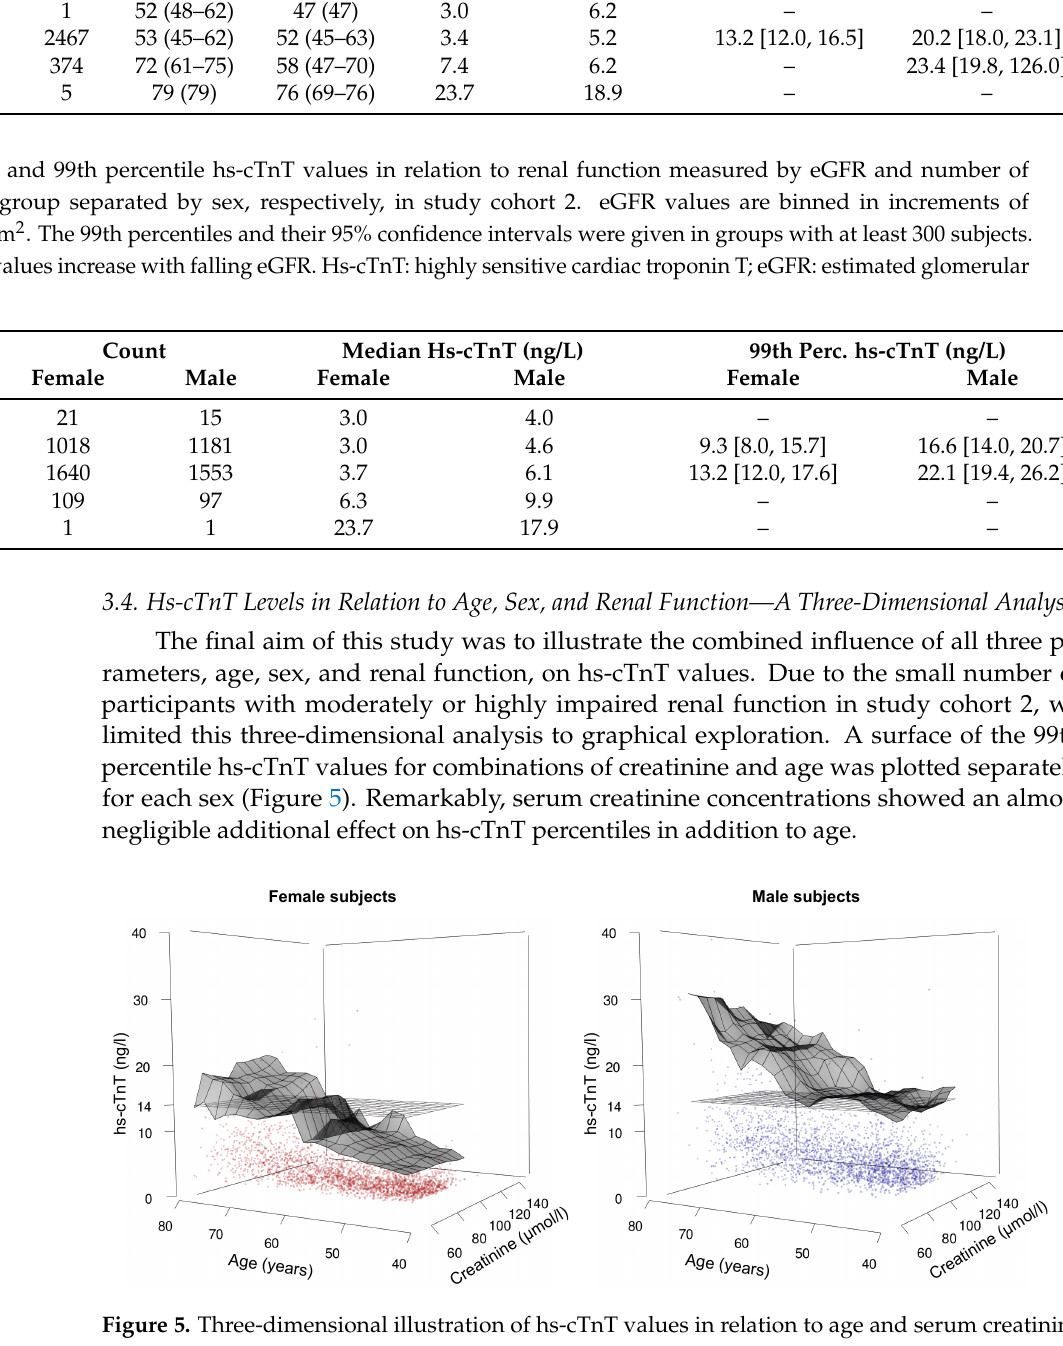
Figure 5. Three-dimensional illustration of hs-cTnT values in relation to age and serum creatinine in study cohort 2 in females (left, red dots) and males (right, blue dots). Floating 99th percentiles are displayed as a grey surface area. In addition to age, serum creatinine concentrations show no discernible added effect on hs-cTnT percentiles. Hs-cTnT: highly sensitive troponin